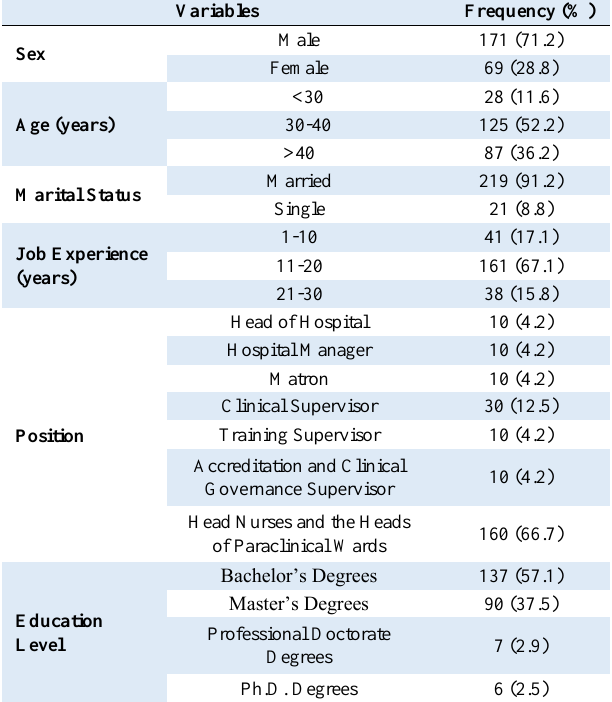
Table 2. Demographic characteristics of the studied managers